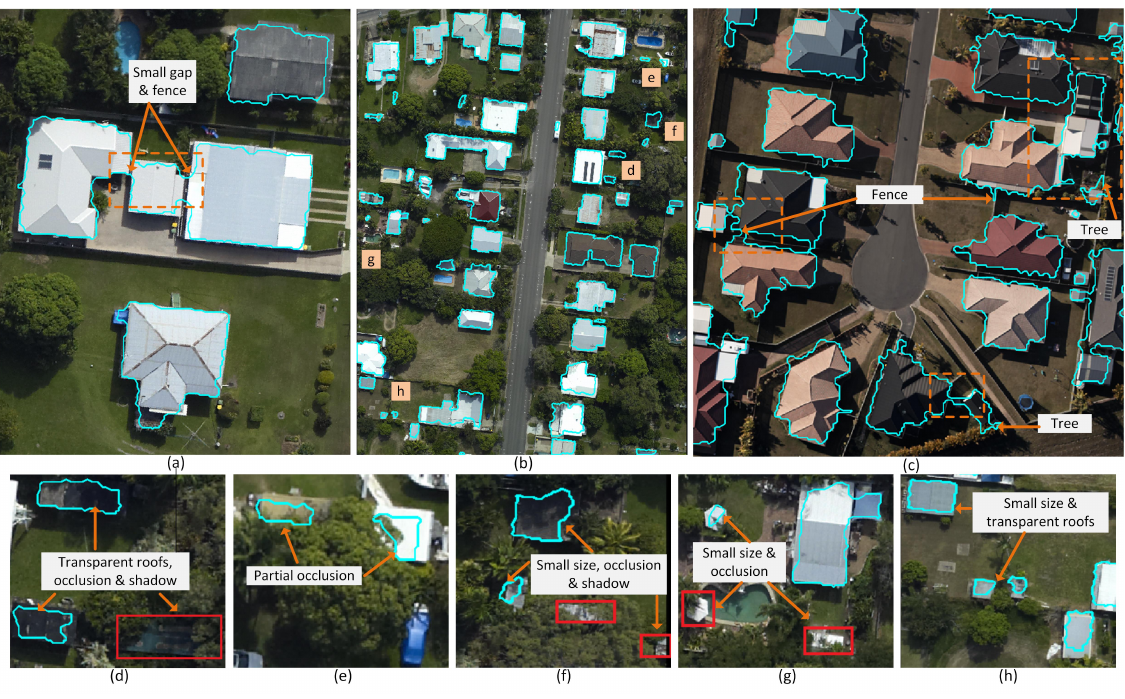
Figure 6. Building detection in (a-b) Aitkenvale (AV1 & AV2) and (c) Hervey Bay (HB) data sets, (d-h) some difficult areas in AV2 data set [marked with letters in (b)]. Cyan coloured polygons indicate detected buildings and red coloured polygons show missing buildings. Table 1. Object-based evaluation results in AV1 - first Aitkenvale, AV2 - second Aitkenvale and HB - Hervey Bay scenes. ( C m = completeness, C r = correctness, Q l = quality, C rd = detection cross-lap rate and C rr = reference cross-lap rate in percentage. C m, 10 , C r, 10 and Q l, 10 are completeness, correctness and quality values for buildings with at least 10 m 2 in area.)